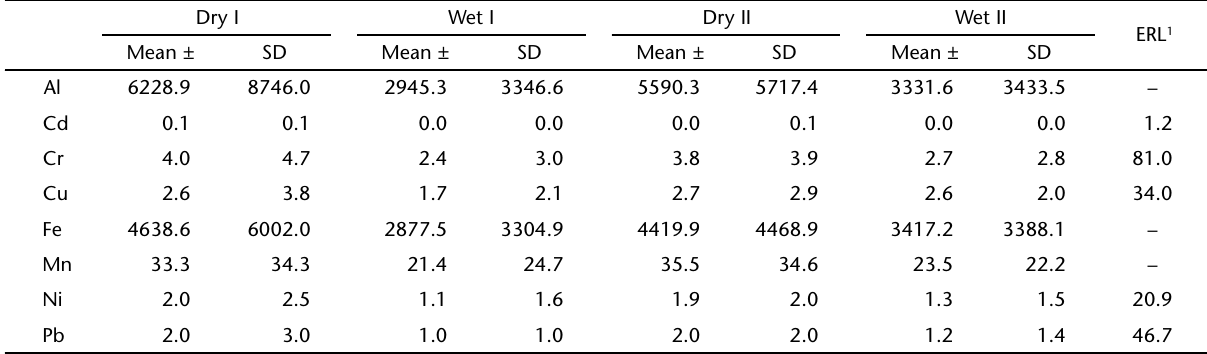
Table IV. Mean heavy metal concentrations (mg.kg -1 ) and standard deviations (SD) in sediments of SJLS per sampling period, compared to reference guidelines for the category of the effect range – low